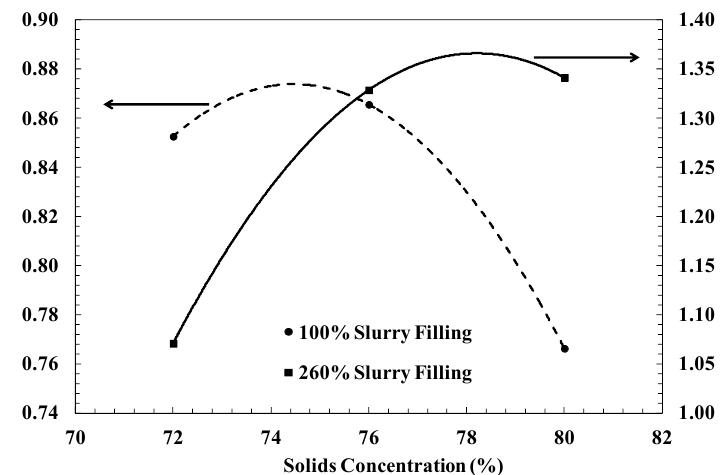
Figure 7. Specific selection functions estimated according to similar fineness of grind considering the influence of percent solids for a slurry filling of 100% for the batch grinding mill.